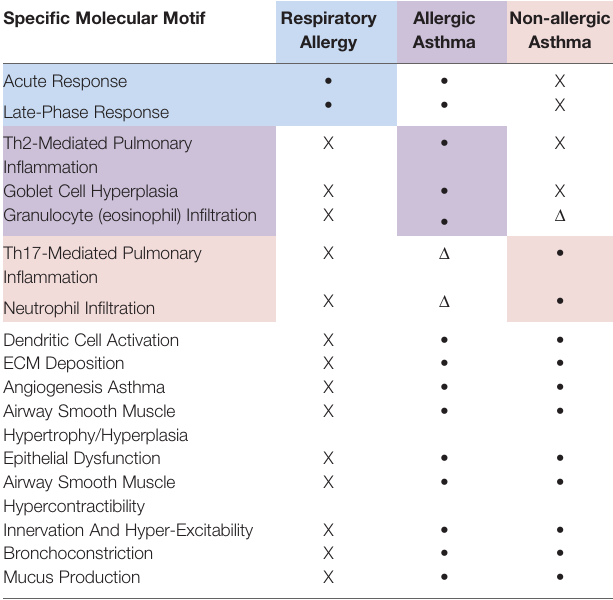
(cid:129) Strong implication of the molecular motif in the disease. D Weaker implication compared to the other variant of asthma, though still relevant. X No implication of the molecular motif in the disease. The strongest differential molecular motifs for each disease are indicated in color (Blue: respiratory allergy, Lilac: allergic asthma, Pink: non-allergic